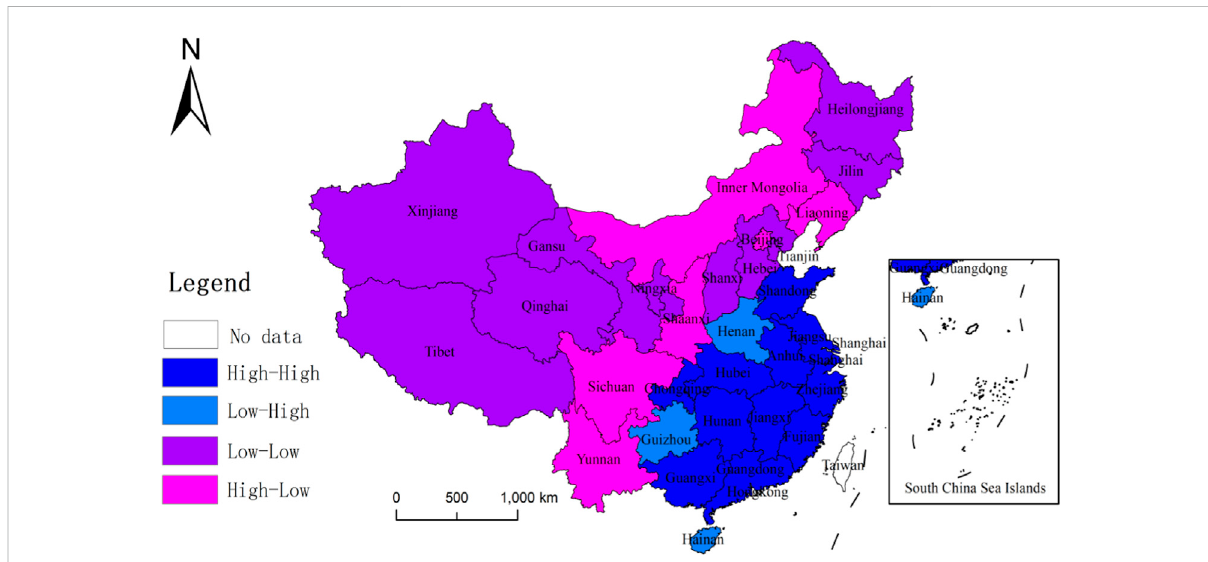
FIGURE 2 Moran scatter plot of inbound overnight tourists from 31 Chinese provinces in